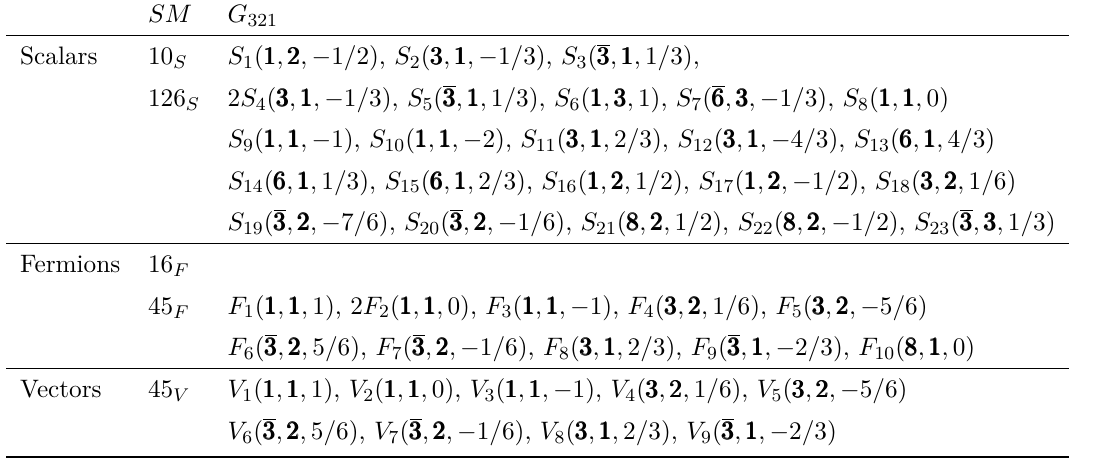
Table 3 . Super heavy scalars, fermions and vector bosons contributing to the GUT threshold cor-